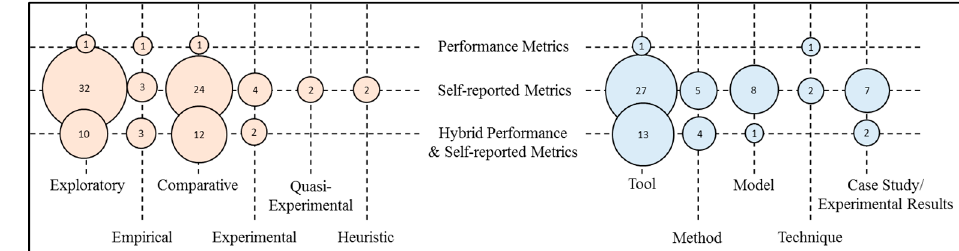
Figure 14. Two-dimensional mapping of research types, contribution types, and metrics.